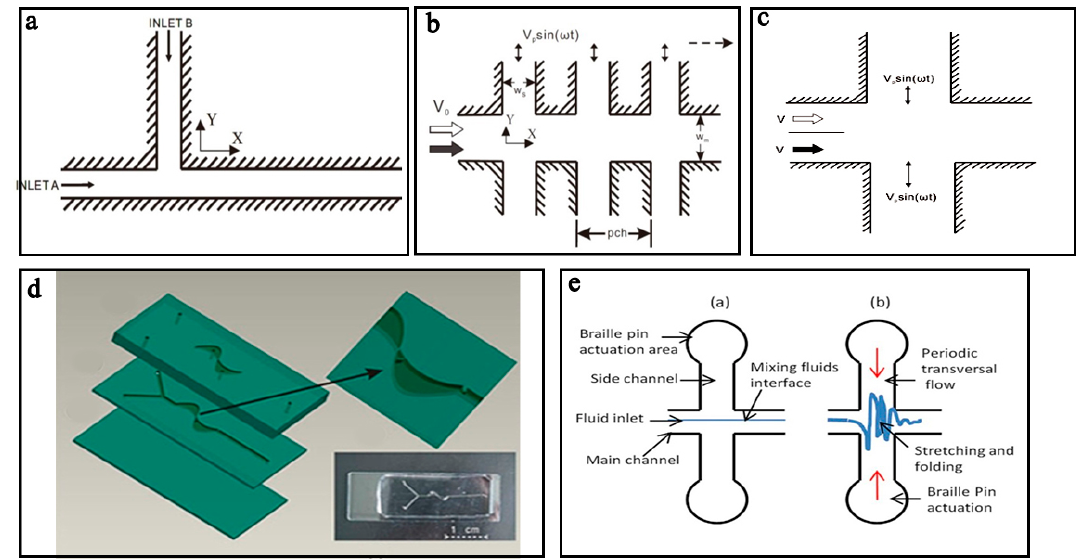
Figure 1. Schematic of pressure field driven micromixers with ( a ) a main channel and a side channel; ( b ) a main channel and multiple side channels; ( c ) two cross channels; ( d ) two mixing chambers, two barriers and two pneumatic chambers; and ( e ) Braille pin actuator. Reproduced with permission from [13,14,64,65].